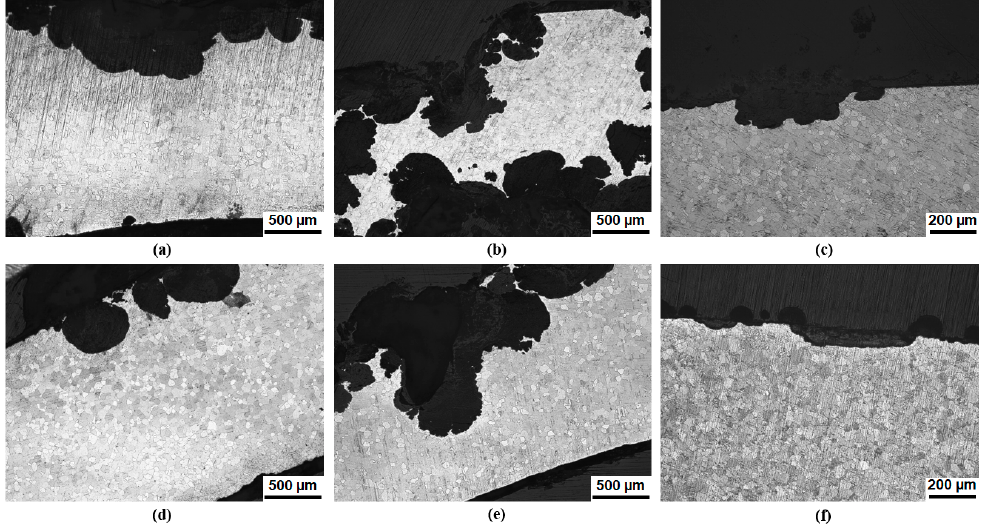
Figure 6. Optical micrographs of corroded C-rings after stress corrosion for over 20 days for the Mg10Dy1Nd ( a , d ), Mg10Dy ( b , e ) and Mg1Nd alloys ( c , f